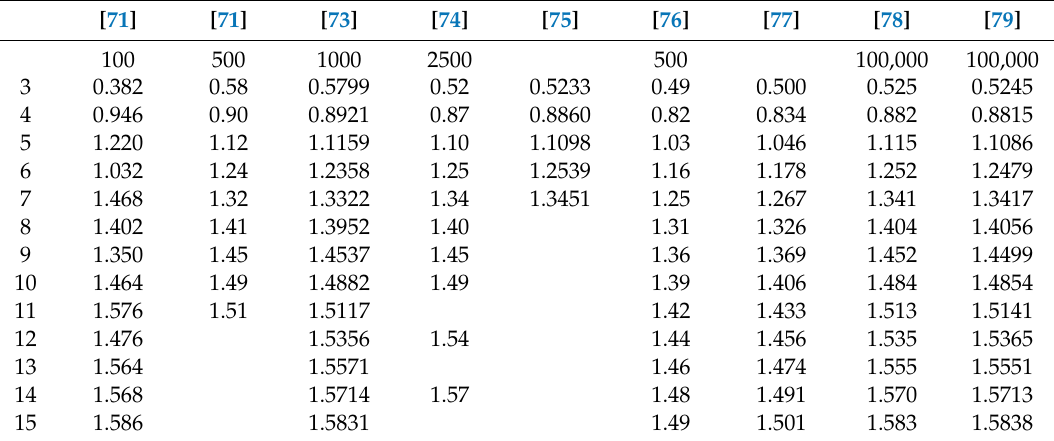
Table 4. RI Values Obtained by Various Authors (Adopted from Reference